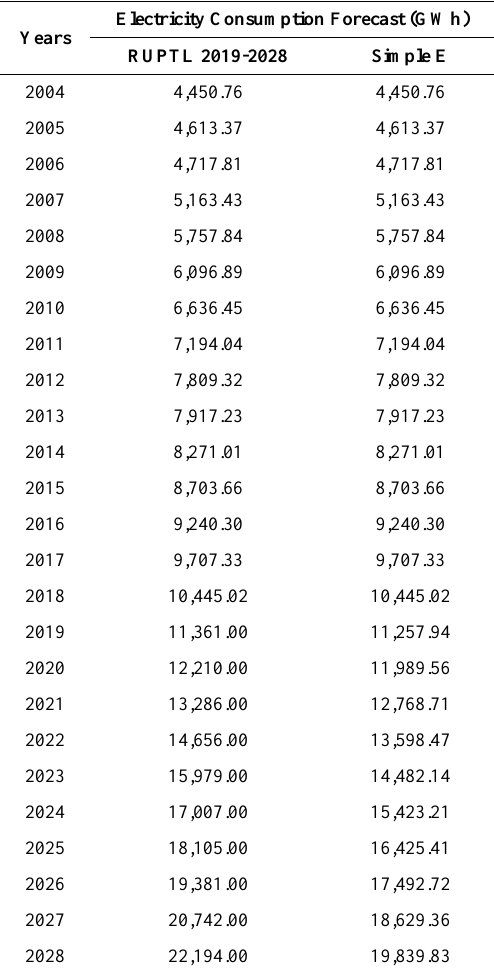
Table 10. Electricity consumption